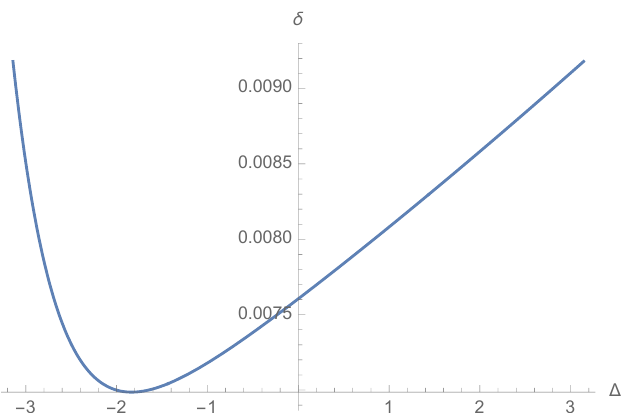
Figure 7. The spatial dependence of the eikonal phase in extremal BTZ at r + = 1 , for a fixed time separation, ∆ t (cid:29) 1 , corresponding to the horizontal dashed line in figure 6. The time separation has been chosen such that the cusp would be on the edges ∆ ϕ = ± π . The cross-over between the exponential and power-law behavior is also visible in this figure, with the location of the trough given by (3.35). The ϕ -dependence of the eikonal phase is encoded in the subleading O ( t 2 ) terms of (3.26). Up to a redefinition φ → ∆ t − ∆ ϕ − log4 r + ∆ t , this precisely matches the shape of the r + shockwave in the extremal limit in [23], after substracting the divergent piece (although the latter shockwave is a priori only valid for t (cid:29) β → ∞